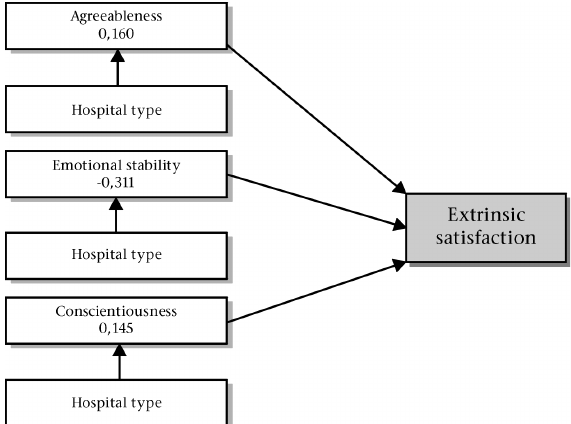
Figure 10: Biographical variables and personality variables as